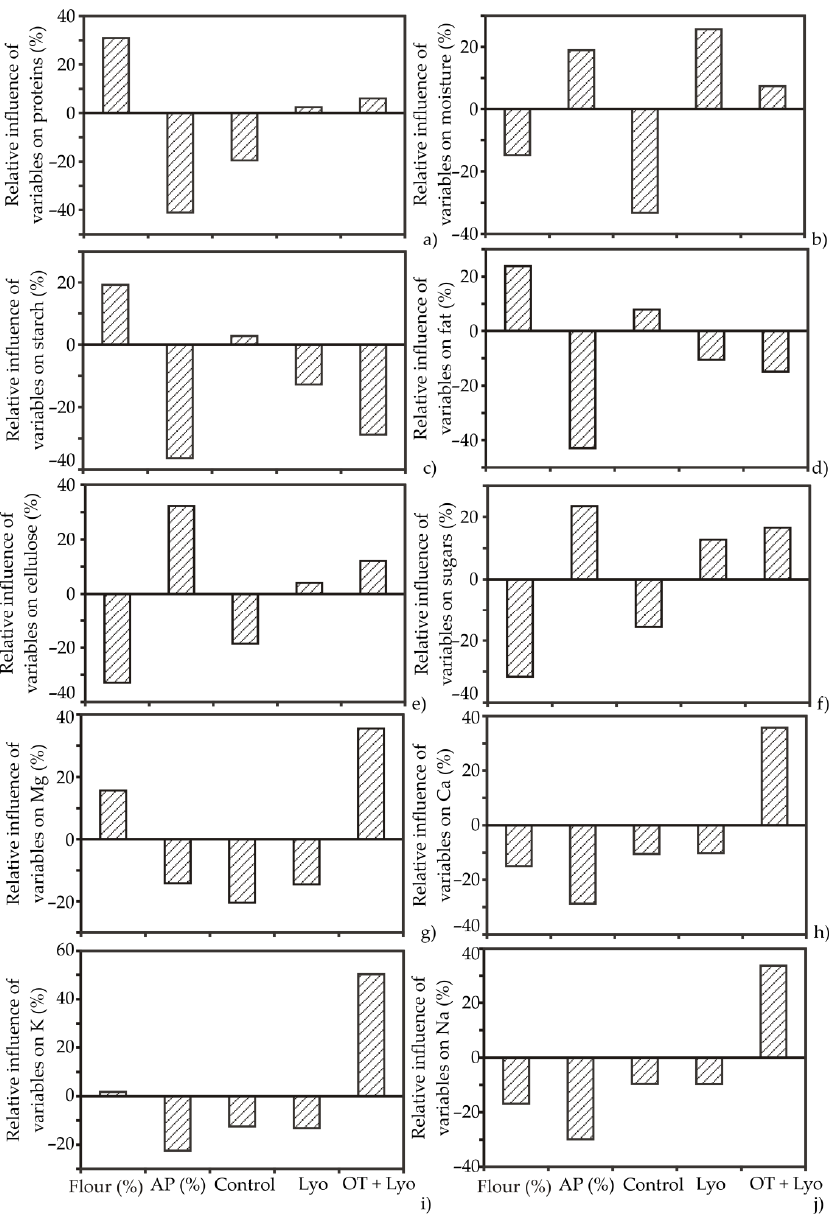
Figure 5. The relative importance of the content of flour, apple powder, and applied treatment on ( a ) proteins; ( b ) moisture; ( c ) starch; ( d ) fat; ( e ) cellulose; ( f ) sugars; ( g ) Mg; ( h ) Ca; ( i ) K; and ( j ) Na, determined using the Yoon interpretation method .